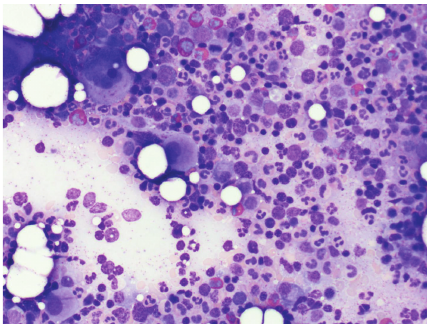
Figure 2: Bone marrow with markedly increased population of cells > 20%, morphologically consistent with blasts. total cells), and increased basophils (4.2%). He underwent